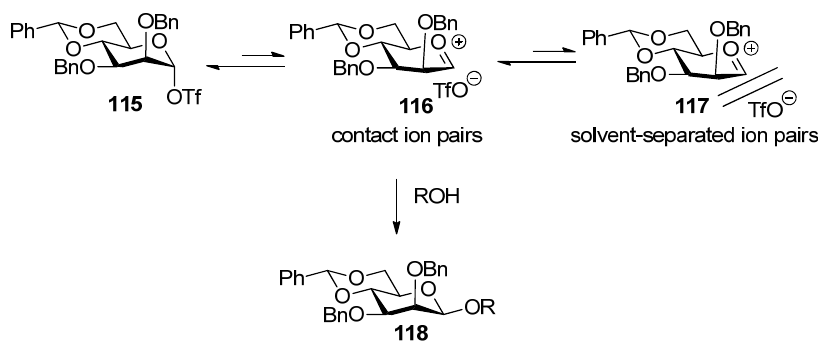
Figure 3. Proposed mechanism for 4,6- O -benzylidene-directed β